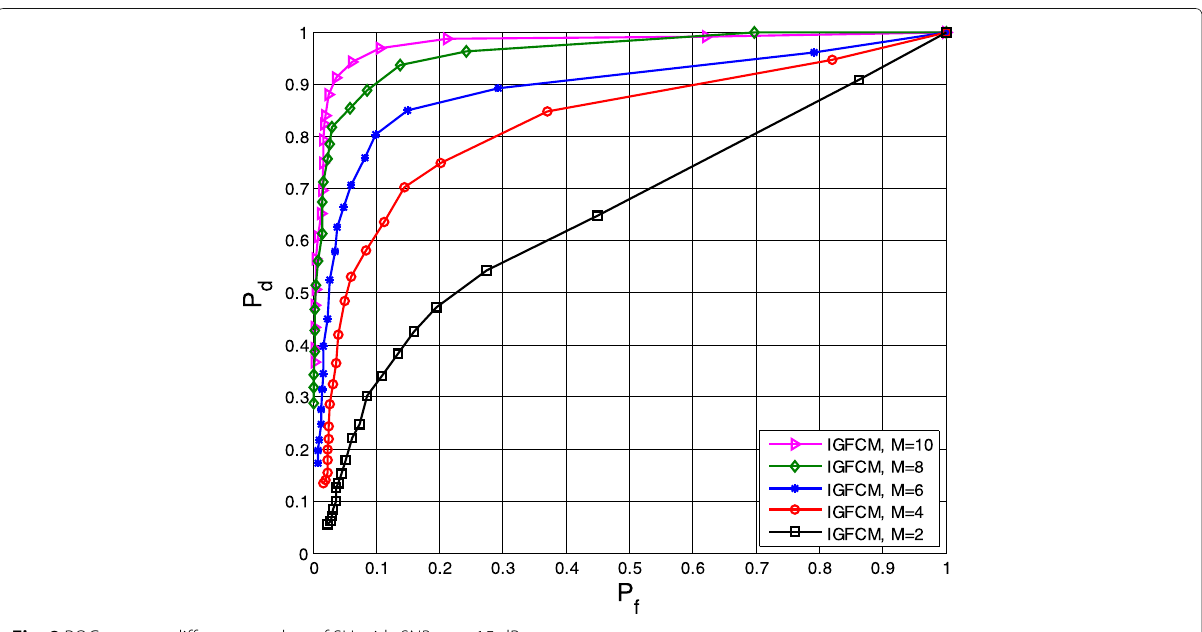
Fig. 8 ROC curve at different number of SU with SNR = − 15 dB